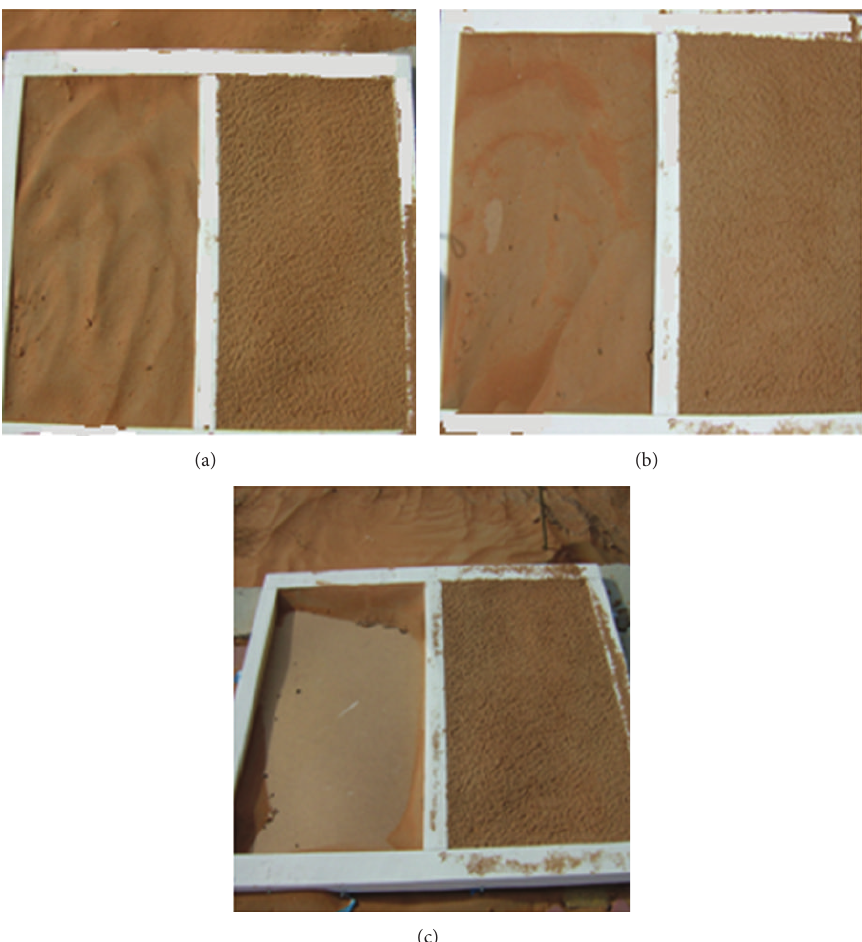
Figure 4: Shows sand erosion in a flatbed formation over 9-week exposure to weathering condition in Al-Ain in which the treated half is completely preserved. (a) After one week, (b) after three weeks, and (c) after nine weeks. 0102030405060708090100110120130140150160